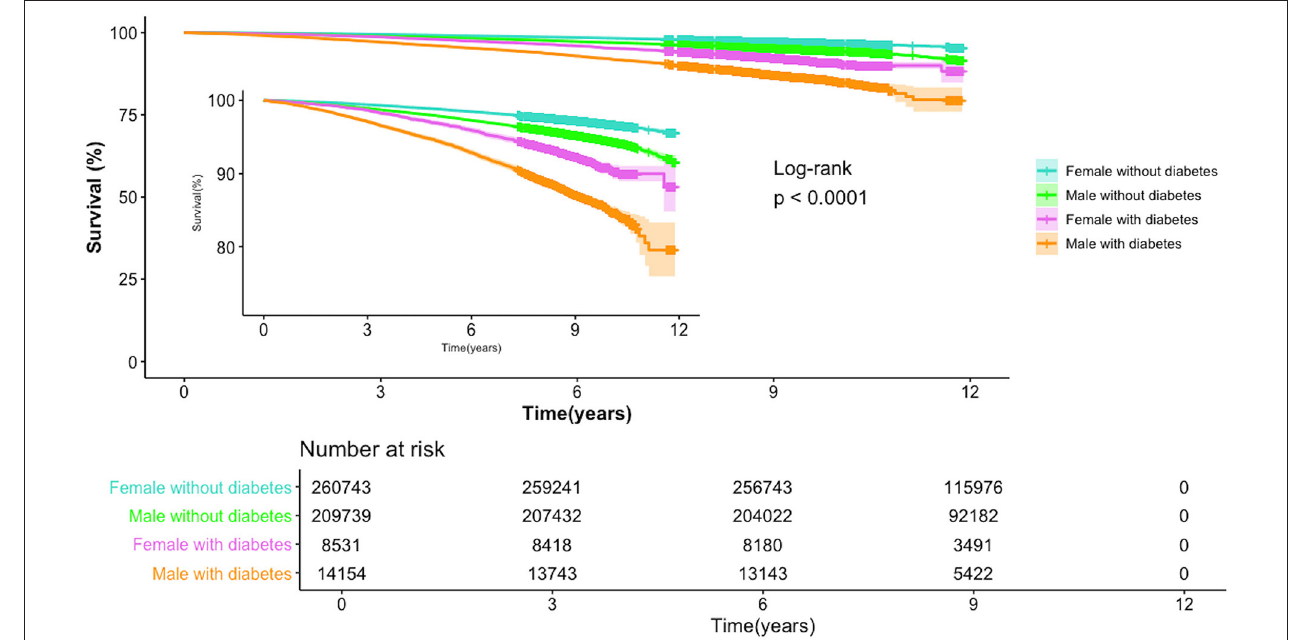
FIGURE 1 | The risk of all-cause mortality according to sex and presence of diabetes.